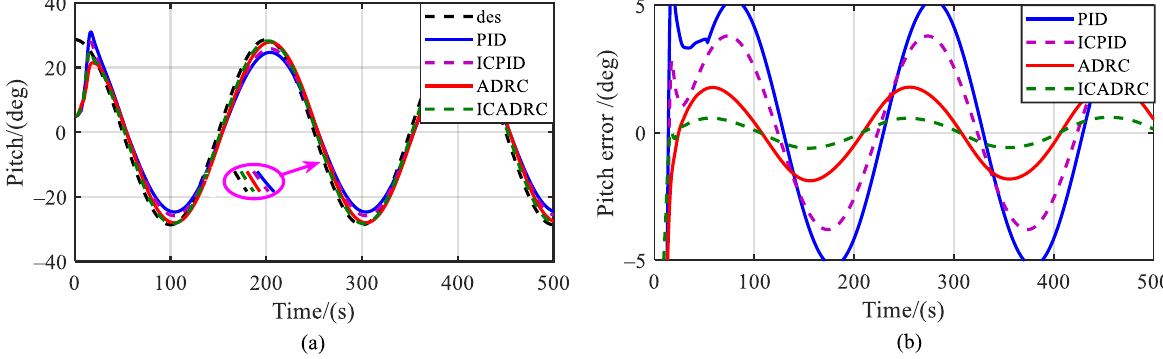
Figure 5. Pitch angle tracking control under square wave signal without external interference. ( a ) The tracking control effects of several controllers under the identical square wave signal; and ( b ) tracking errors of several controllers.